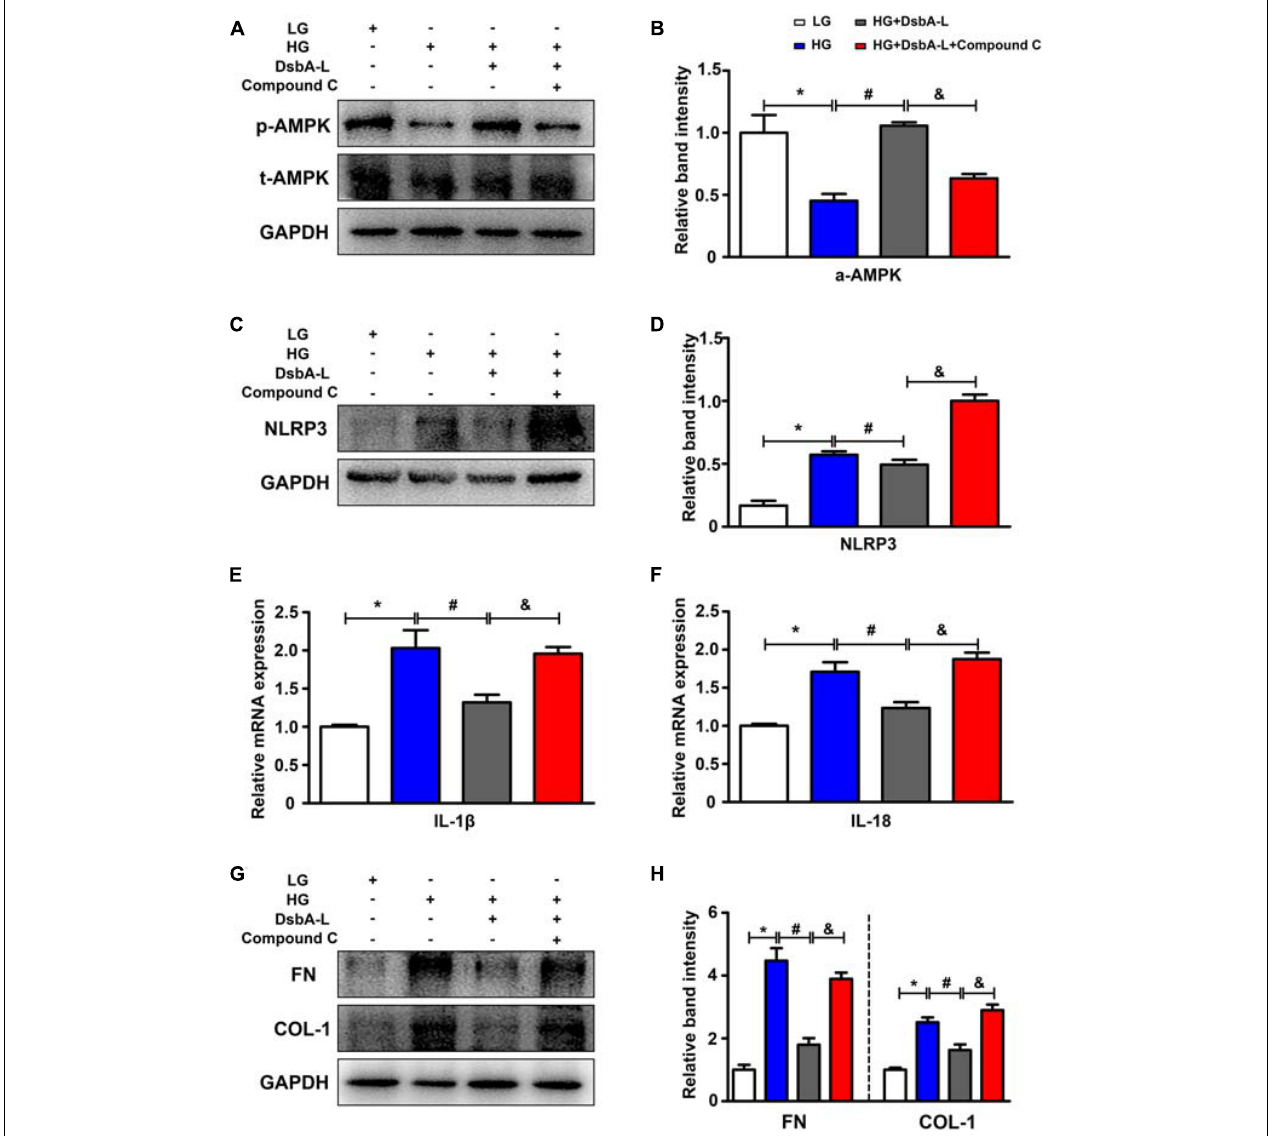
FIGURE 4 | Altered AMPK phosphorylation and NLRP3 expression in HK-2 cells treated with HG treatment. (A,B) The expression of p-AMPK and total AMPK in HK-2 cells exposed to different treatments. (C,D) The expression of NLRP3 in HK-2 cells exposed to different treatments. (E,F) The mRNA level of IL-1 β and IL-18 in HK-2 cells exposed to different treatments. (G,H) The expression of FN and COL-1 in HK-2 cells exposed to different treatments. The values are the mean ± SD. n = 3/group. * p < 0.05 compared with the LG group; # p < 0.05 compared with the HG group; & p < 0.05 compared with the HG +DsbA-L